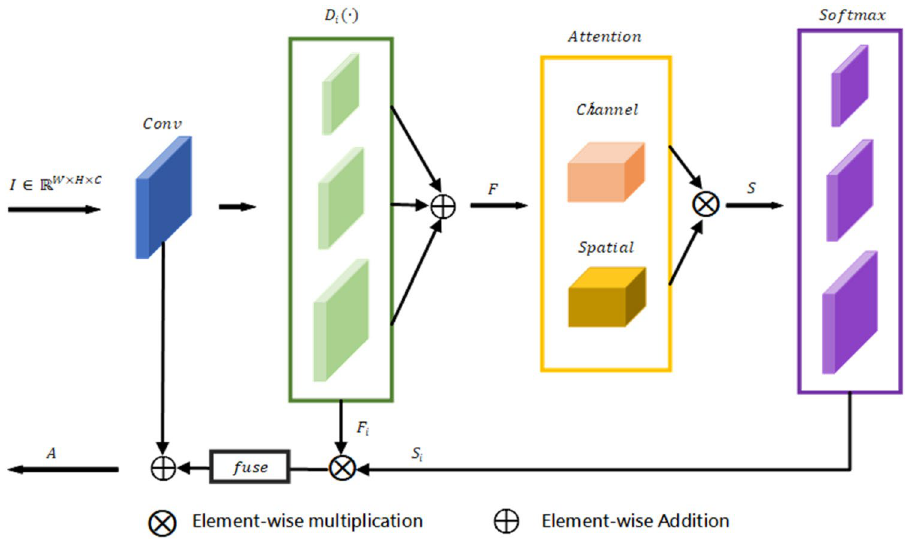
Figure 3. Multiscale attention